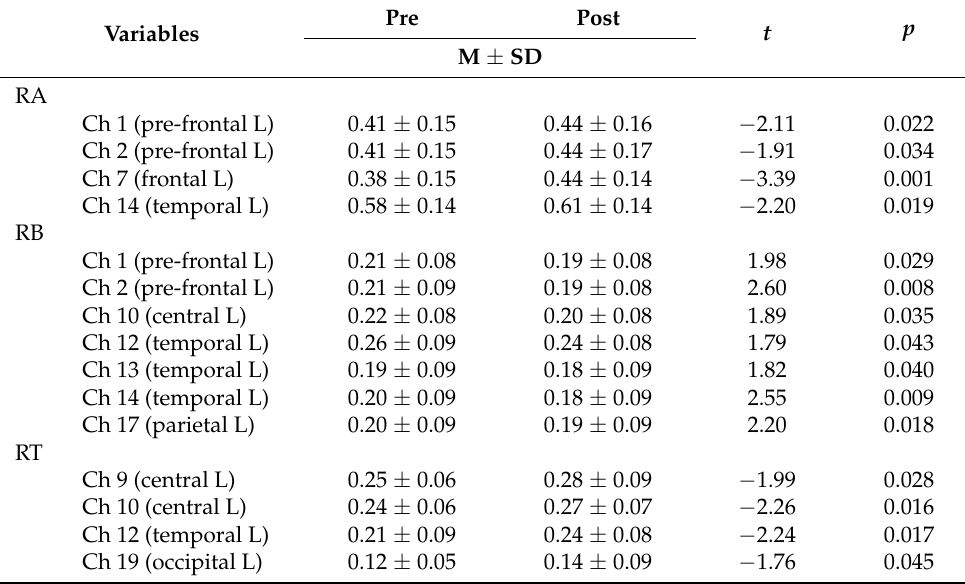
Table 4. Differences in Brain Waves ( n =